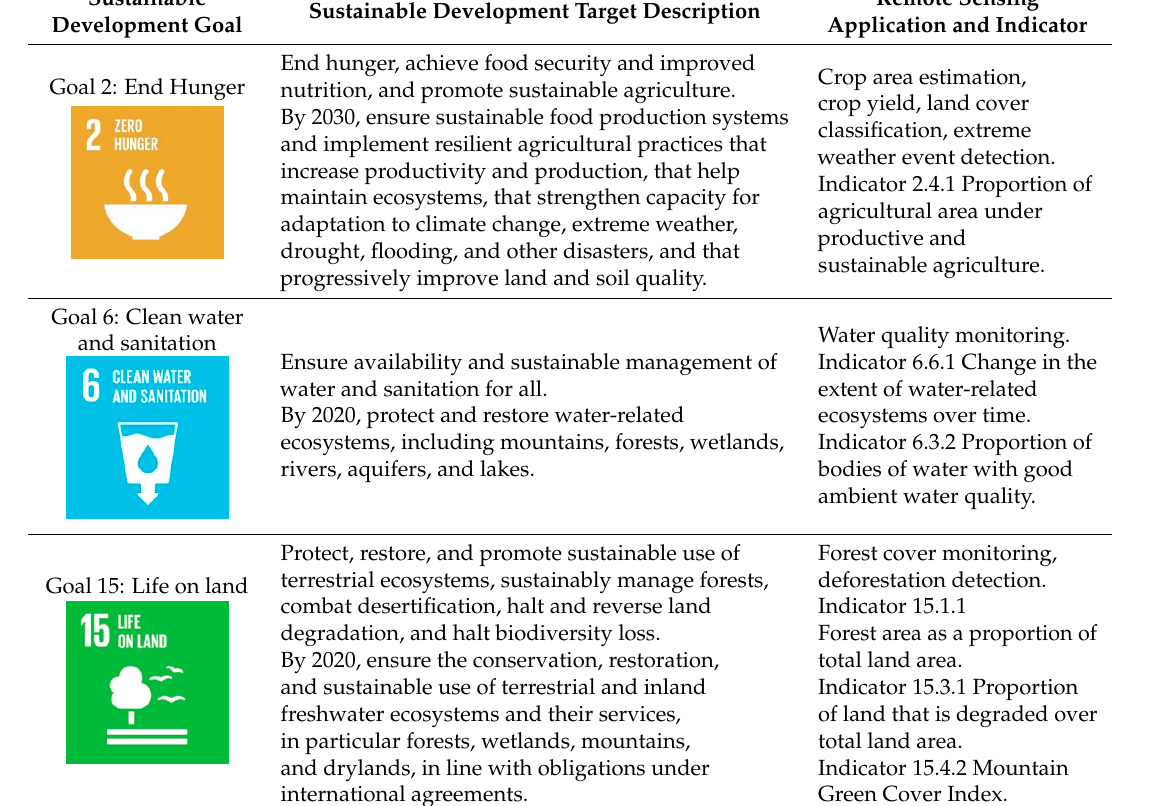
Table 1. Remote sensing data, as used to measure UN Sustainable Development Goals.